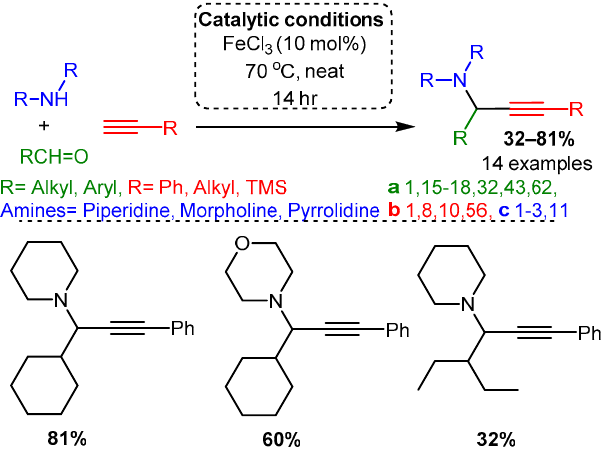
Scheme 23. Iron-catalysed A 3 coupling reaction in open air and absence of